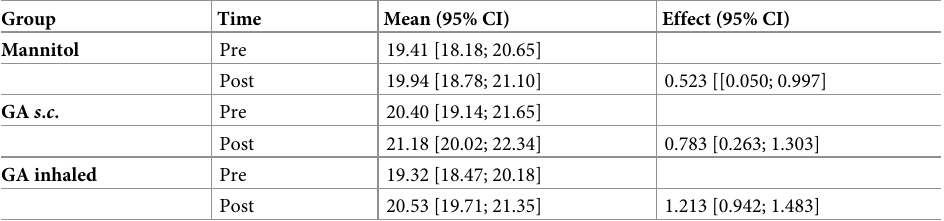
Table 1. GA inhalation effect on bronchoconstriction measured as peak pressure, P peak